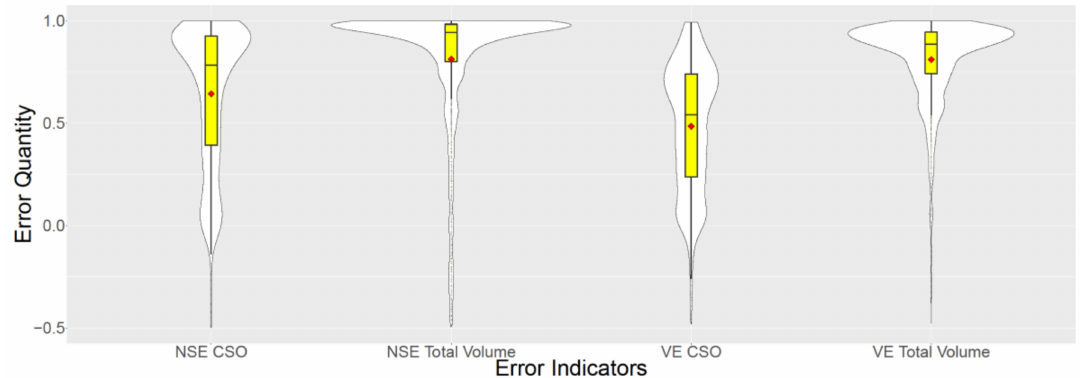
Figure 9. Comparison between distributions of emulation error indicators NSE ( left ) and VE ( right ) for CSO predictions vs. total volume predictions. Red square shows the mean